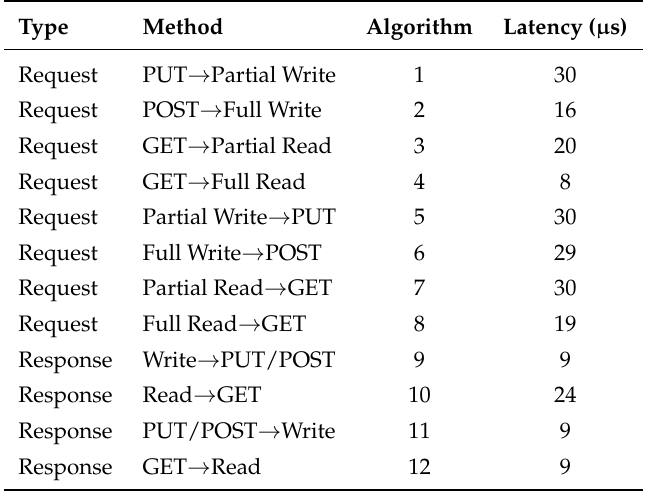
Table 3. Latency of mapping methods running on the ESP-based